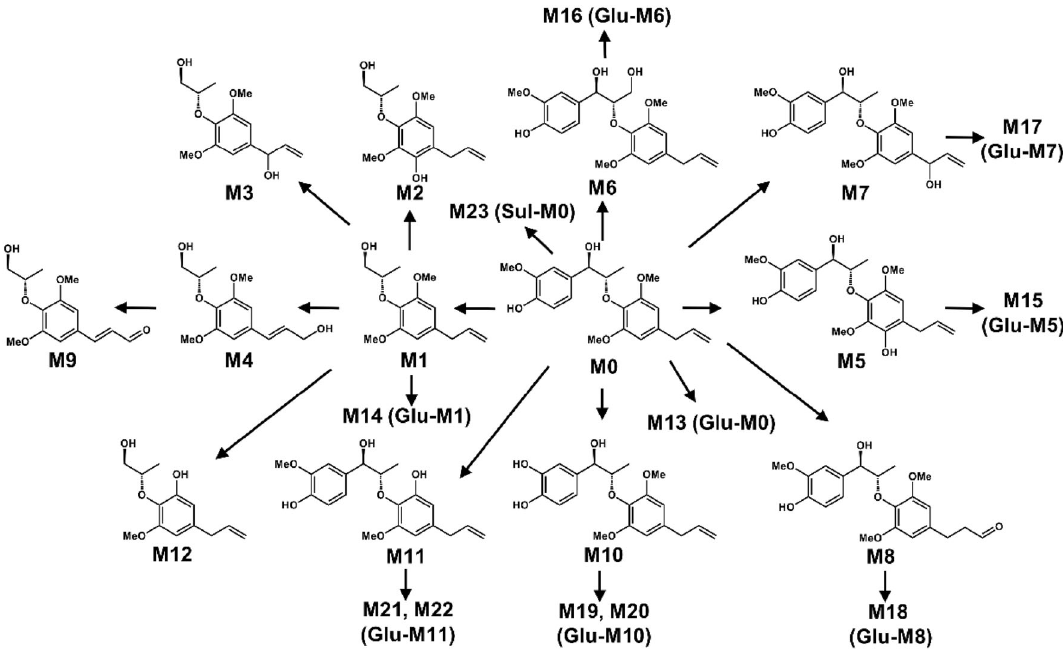
Fig. 4 Metabolic map of myrislignan by using metabolomics. Reproduced with permission from [12]